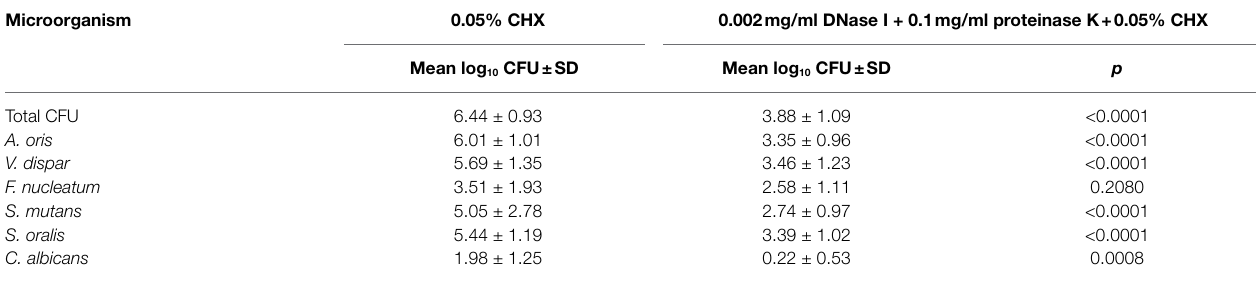
TABLE 2 | Mean log 10 CFU counts of the whole biofilm (total CFU) and the six microorganisms used in the biofilm model when treated with 0.05% CHX compared to the combined treatment with enzymes plus 0.05% CHX alone ( n = 6).